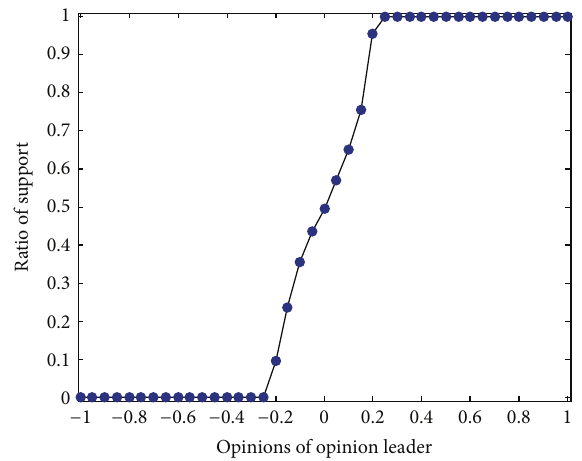
Figure 14: When 𝑎 = 0.7 , 𝑏 = 0.3 , and 𝑐 = 0 , supportive ratio changes with the opinion of opinion leaders. Each data point is an average over 30 independent